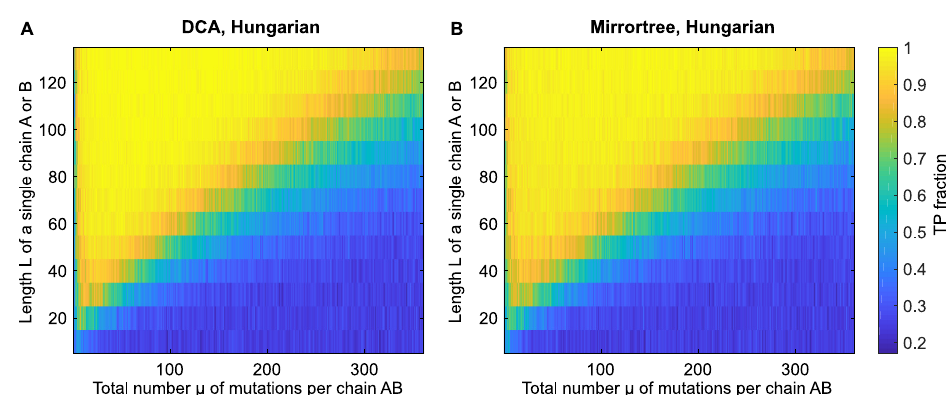
Fig 4. Performance of DCA- and Mirrortree-based predictions for various data parameters. The fraction of pairs AB correctly predicted (TP fraction) is shown versus the average total number of mutations μ per chain AB and the length L of a single chain A or B for DCA (panel A ) and Mirrortree (panel B ). The Hungarian algorithm was employed to predict pairings. For each μ and L , data was generated using a tree of n = 10 generations, thus yielding 1024 chains AB, and random species, each comprising 4 chains AB, were constructed. Half of the species were chosen to form a training set of 512 pairs, and predictions were made on the remaining species, which form the testing set. Here the chance expectation of TP fraction, obtained for random within-species pairings, is